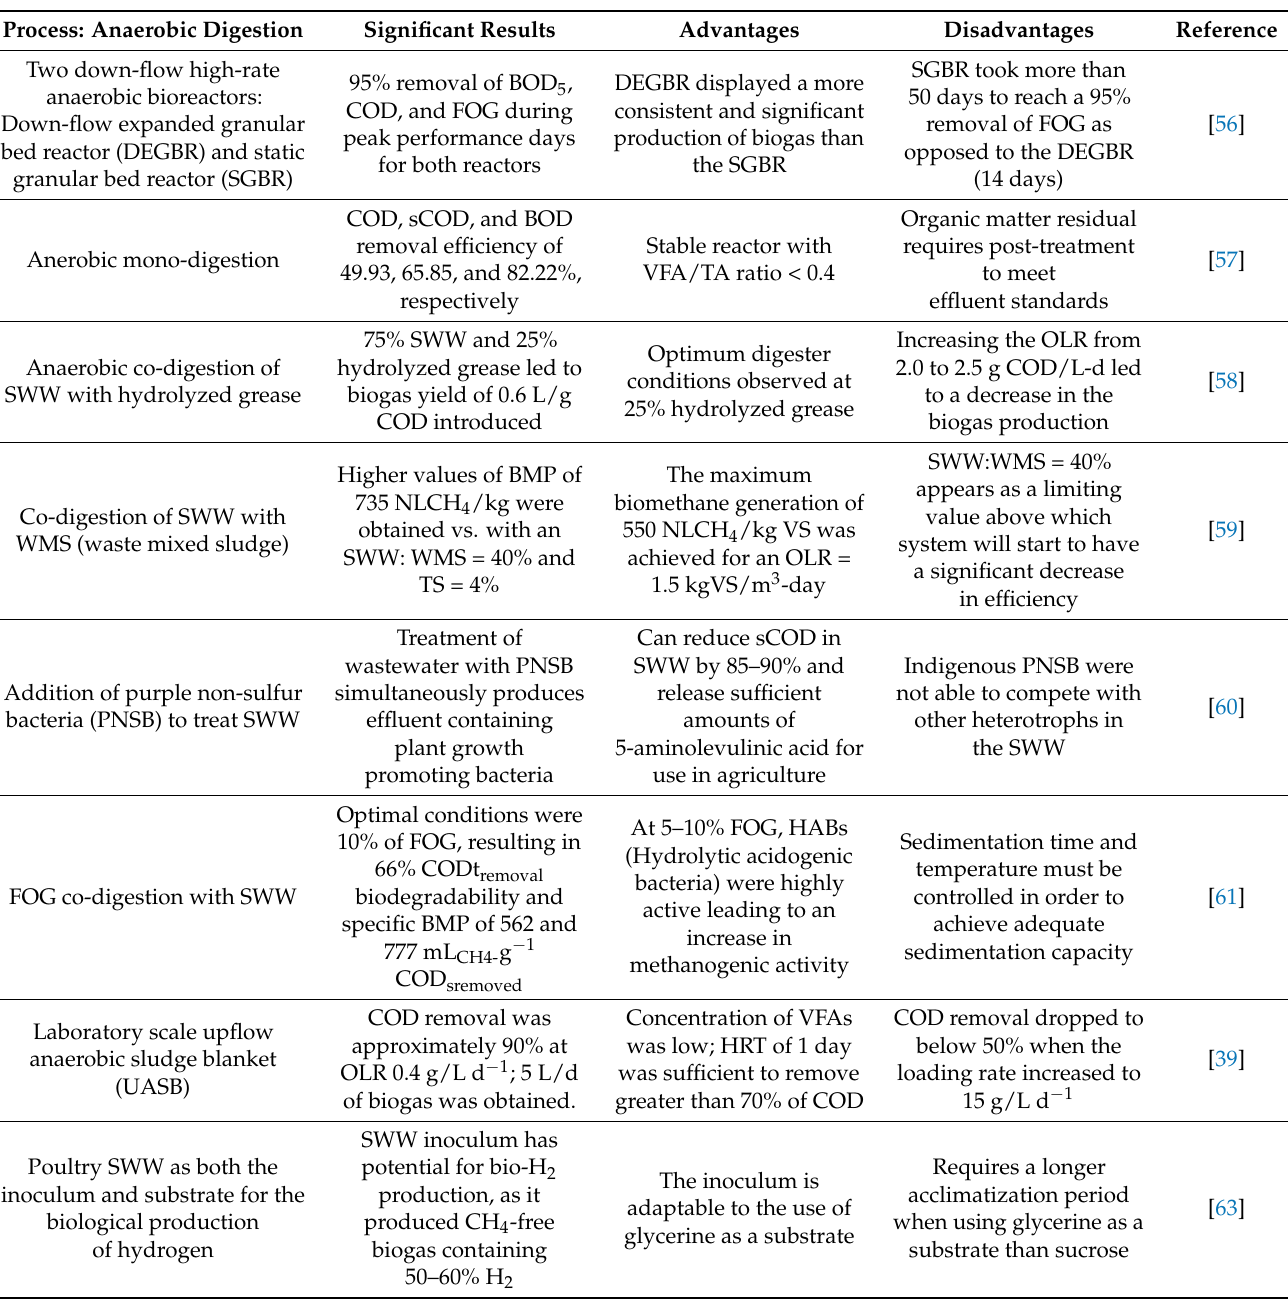
Table 2. Biological treatment methods/biomethane production for SWW. Abbreviations for common terms in table